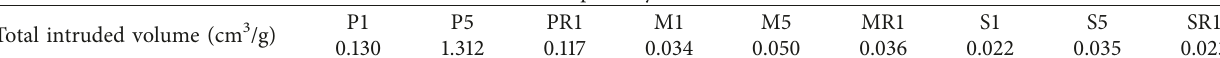
Table 5: The porosity of matrices.